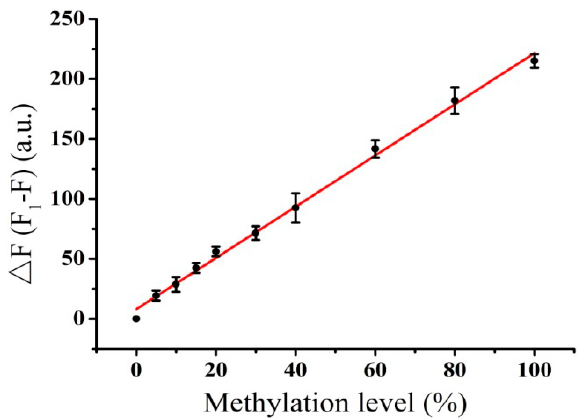
Figure 5. The linear relationship between ∆ F (Y) and methylation level (X) ranging from 0% to 100% (5%, 10%, 15%, 20%, 30%, 40%, 60%, 80%, and 100%). Error bars represent the standard deviation of three experiments.